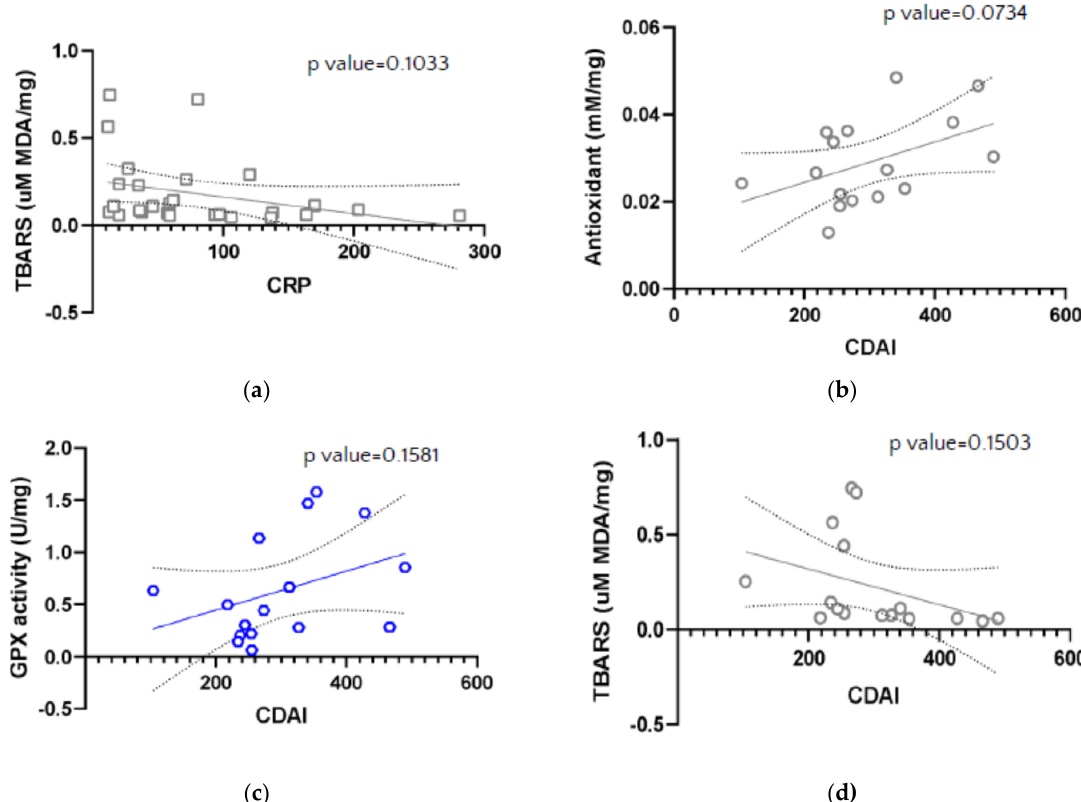
Figure 5. Correlation between Thiobarbituric Acid Reactive Substances (TBARS) presented as concentration of malondialdehyde (MDA, uM MDA/mg sample) and value of C-reactive protein (CRP) ( a ), and between antioxidant concentration (mM/mg) ( b ), GPX activity (U/mg) ( c ), Thiobarbituric Acid Reactive Substances (TBARS) presented as concentration of malondialdehyde (MDA, uM MDA/mg sample) ( d ) and Crohn’s Disease Activity Index (CDAI) in IBD patients.